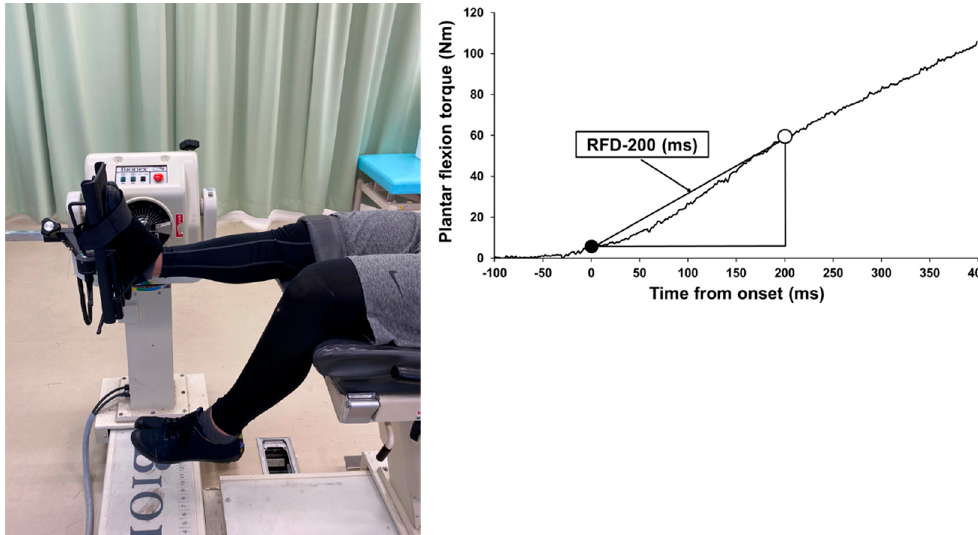
Figure 1. The experimental set-up for plantar flexor strength measurement and typical example of rate of force development (RFD) at 200 ms (with filtering correction).